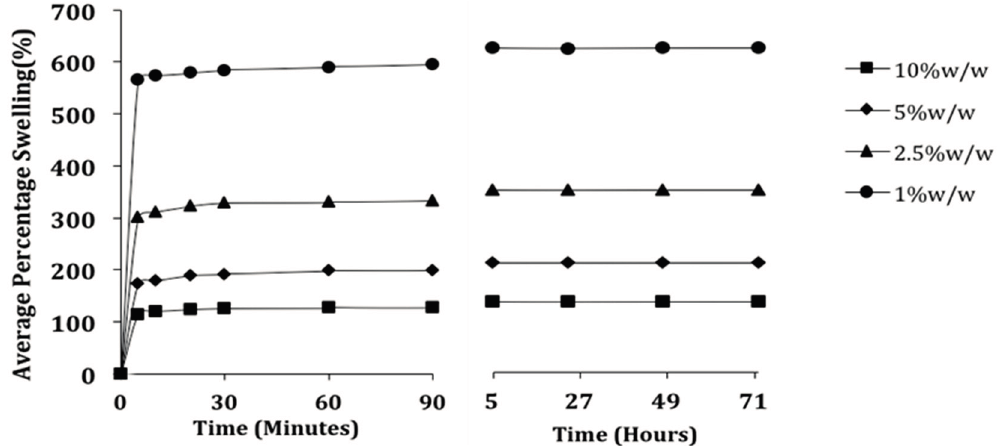
Figure 2. Effect of PETRA concentration on the % swelling values of PEO